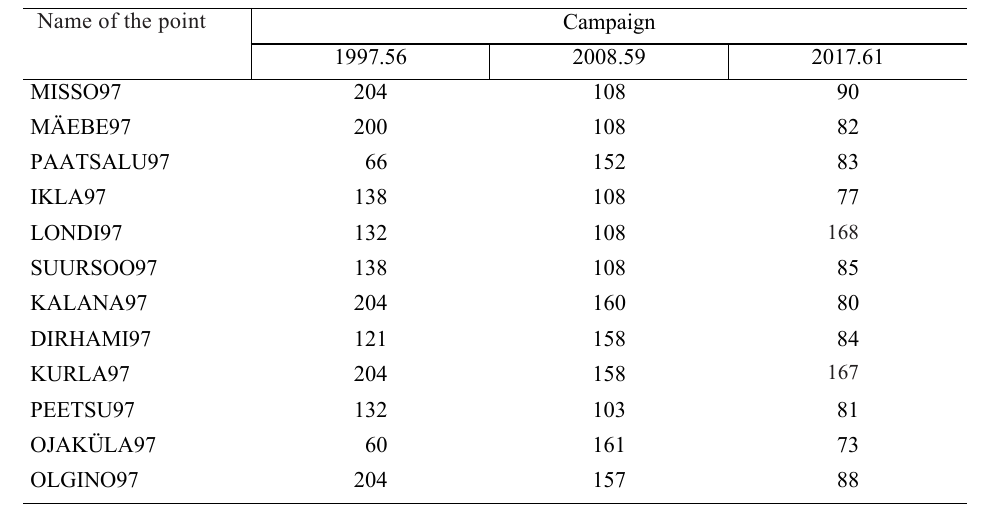
Table 1. The observation lengths of GRN points in hours